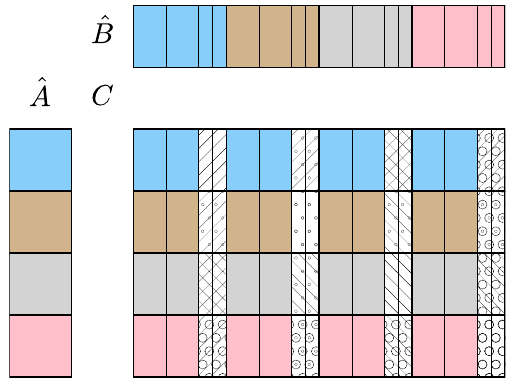
Figure 3. The LTS optimization.